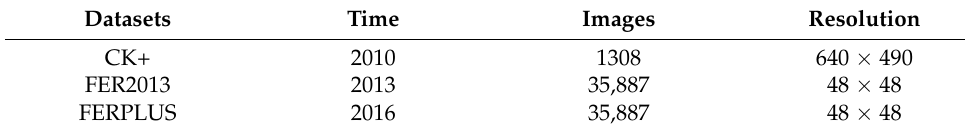
Table 1. The image resolution of common datasets for facial expression recognition.